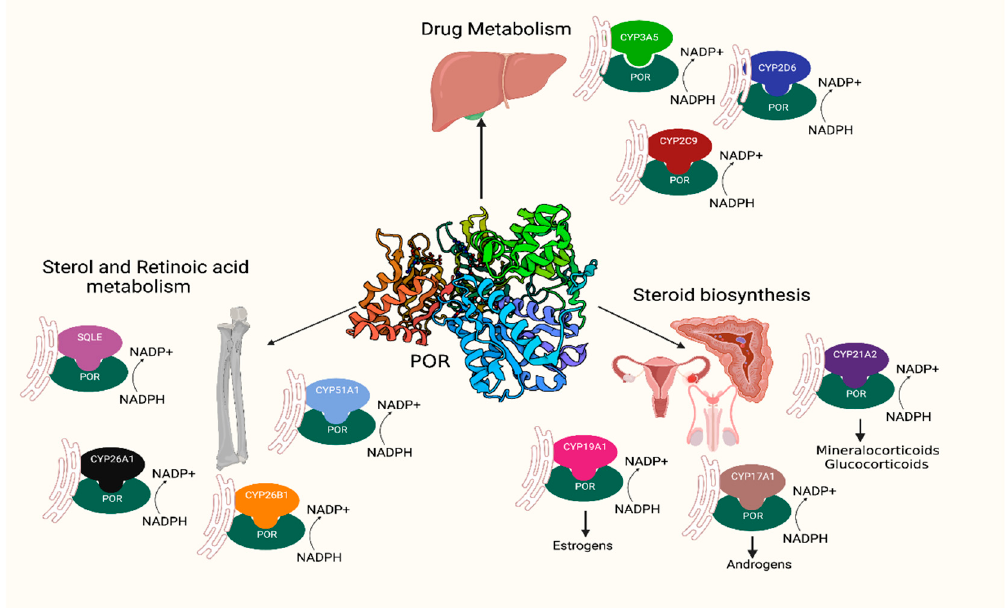
Figure 1. POR is a key enzyme in several metabolic processes, such as drug metabolism, steroid biosynthesis, and sterol and retinoic acid metabolism. POR provides the necessary equivalents from NADPH to its multiple redox partners to accomplish their functions.